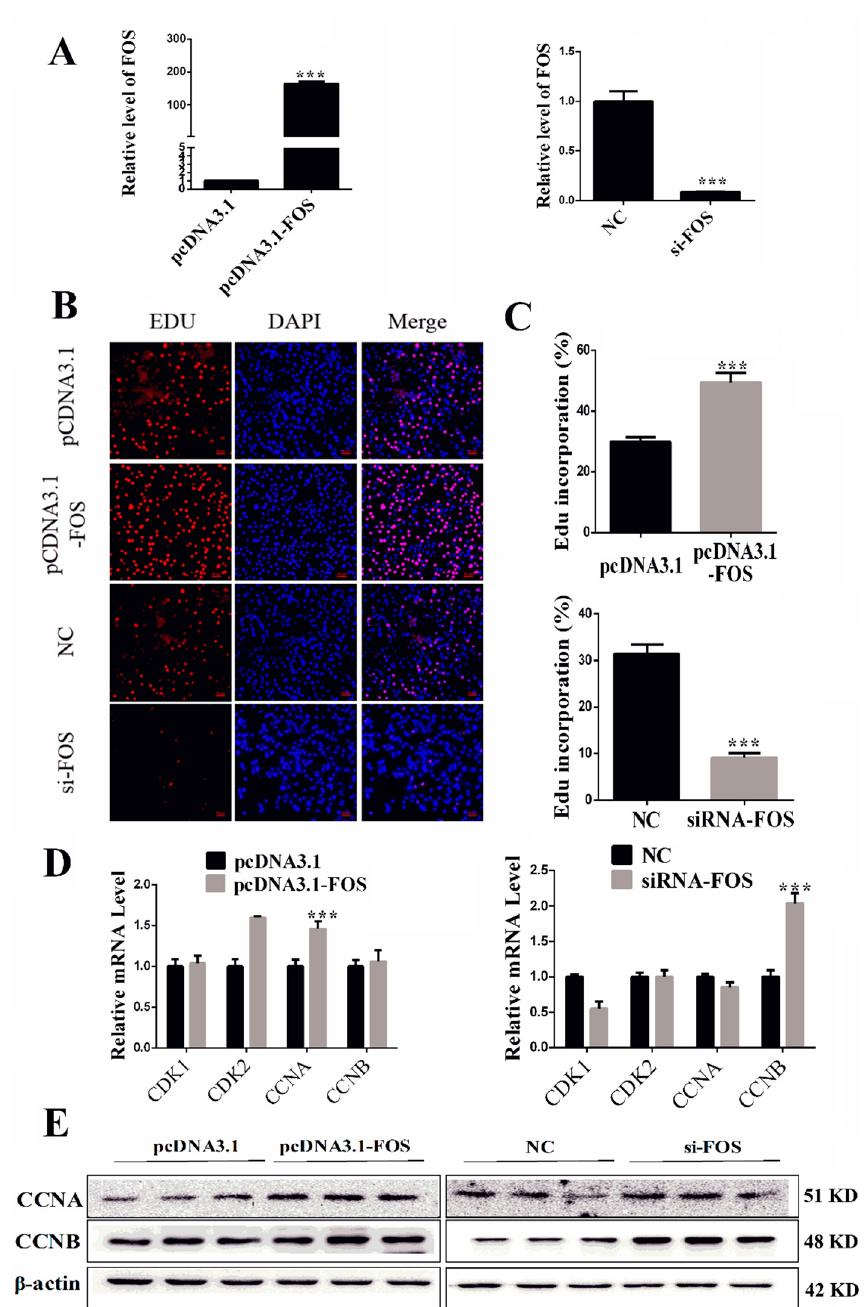
Figure 5. Overexpressing FOS promotes C2C12 proliferation. ( A ) Overexpressing or inhibiting FOS expression through transfecting C2C12 with pcDNA3.1( + )-FOS recombinant vector and siRNA-FOS, respectively. ( B ) Overexpressing FOS increased the percentage of Edu-positive C2C12, and interfering FOS decreased the percentage of Edu-positive C2C12. Representative images of the immunofluorescent proliferating C2C12 are shown. Proliferating C2C12 were labeled with Edu fluorescent dye (red). ( C ) The quantitative data of proliferating C2C12 number in Figure 5B. ( D ) qRT-PCR confirmed the mRNA level of proliferation-related genes in C2C12 transfected with pcDNA3.1( + )-FOS recombinant vector and siRNA-FOS, respectively. ( E ) Western blot result shows that the protein level corresponded to the mRNA result. *** p ＜ 0.001. All the results are presented as mean ± S.E.M. of three replicates for each group. Magnification 100×. The scale bars on the photomicrographs represent 50 μ m.